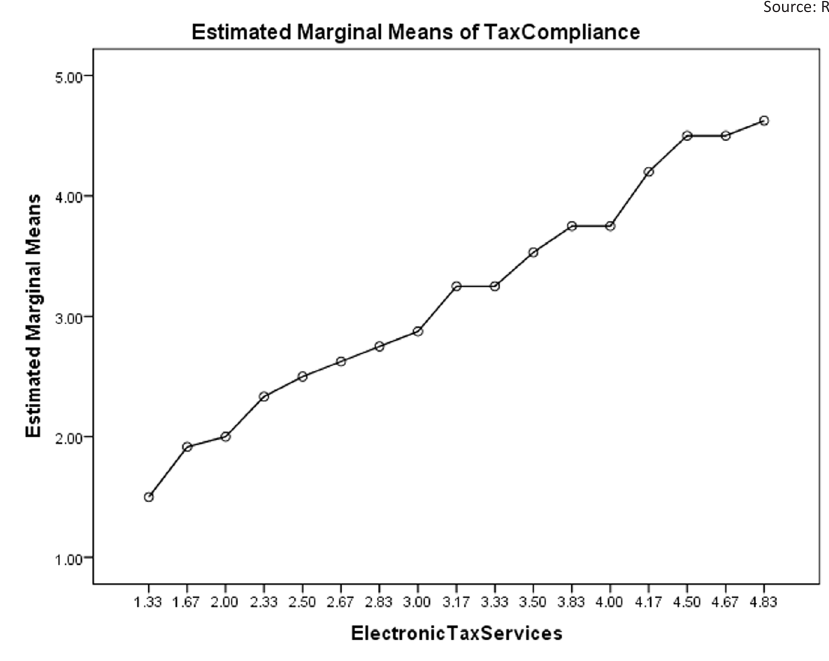
Figure 1. Influence of E-tax System on Tax Compliance in Nigeria